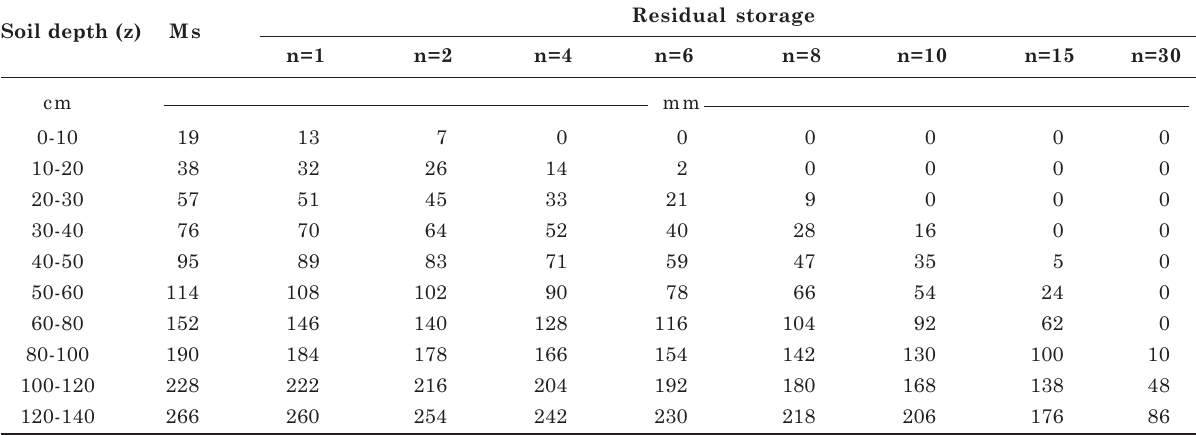
Ms: maximum water storage in the layer.